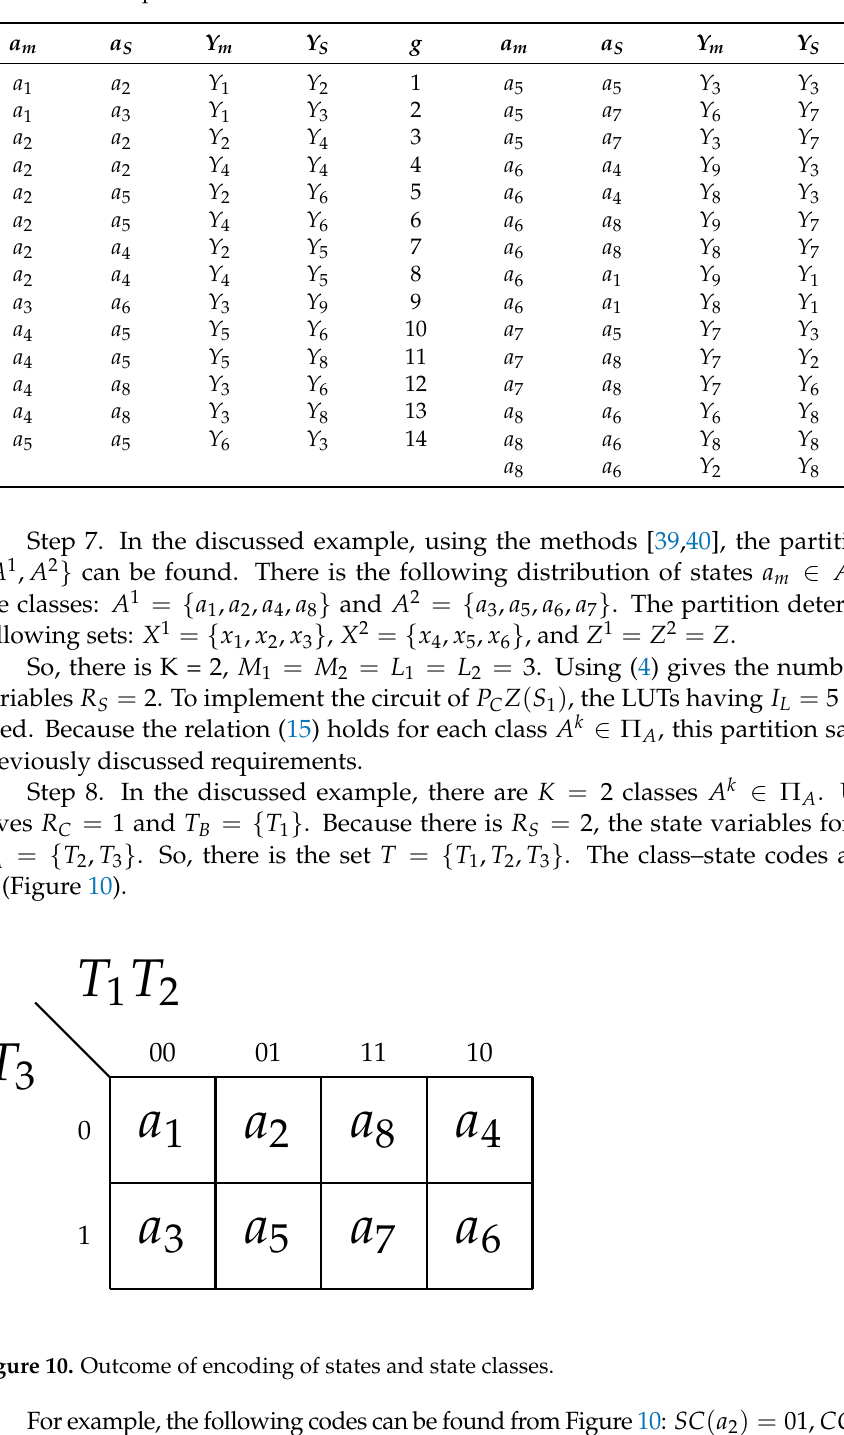
Table 3. Table of pairs of COs